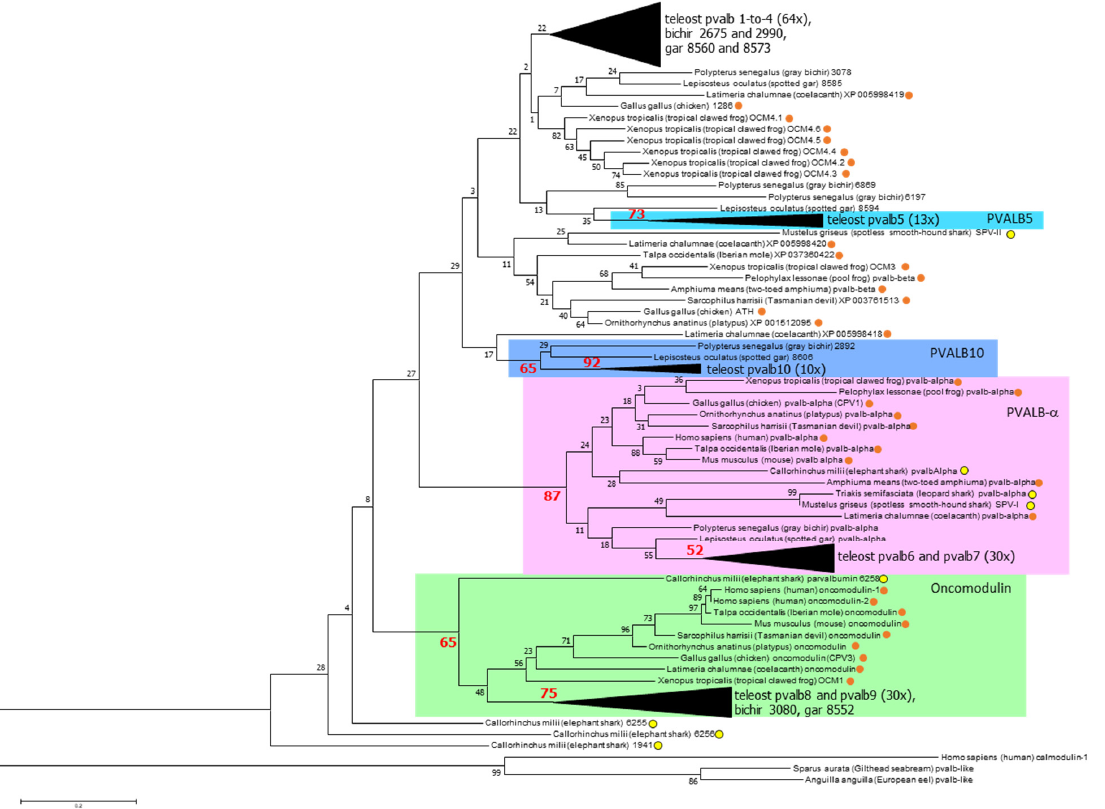
Figure 4. Molecular Phylogenetic analysis by Maximum Likelihood method. The percentage of trees in which the associated taxa clustered together is shown next to the branches, and important values >50 are highlighted in large red font. The tree is drawn to scale, with branch lengths measured in the number of substitutions per site. Clusters with teleost sequences (including sometimes also non ‐ teleost sequences) are condensed; for a non ‐ condensed tree and full descriptions see Supplementary File S4A. This type of analysis can not clearly distinguish between teleost pvalb1, ‐ 2, ‐ 3, and ‐ 4, between teleost pvalb6 and ‐ 7; and between teleost pvalb8 and ‐ 9 (Supplementary File S4; see also [26]). Yellow and orange circles highlight parvalbumin sequences of sharks/rays/chimeras and lobe ‐ finned ‐ fish/tetrapods, respectively.